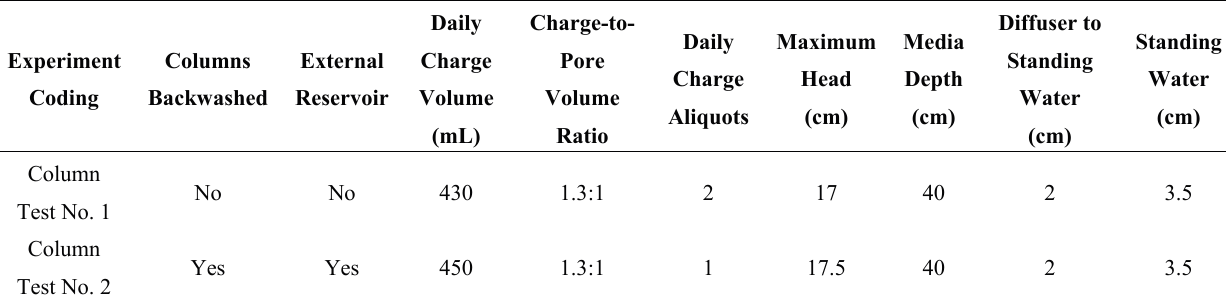
Figure 2. Cross-section of bench-scale columns used in Column Test No. 2. Six columns of this design were used, three loaded with Accusand silica and three with crushed granite media. Table 1. Characteristics of filter columns, media preparation and daily charge for Column Tests No. 1 and